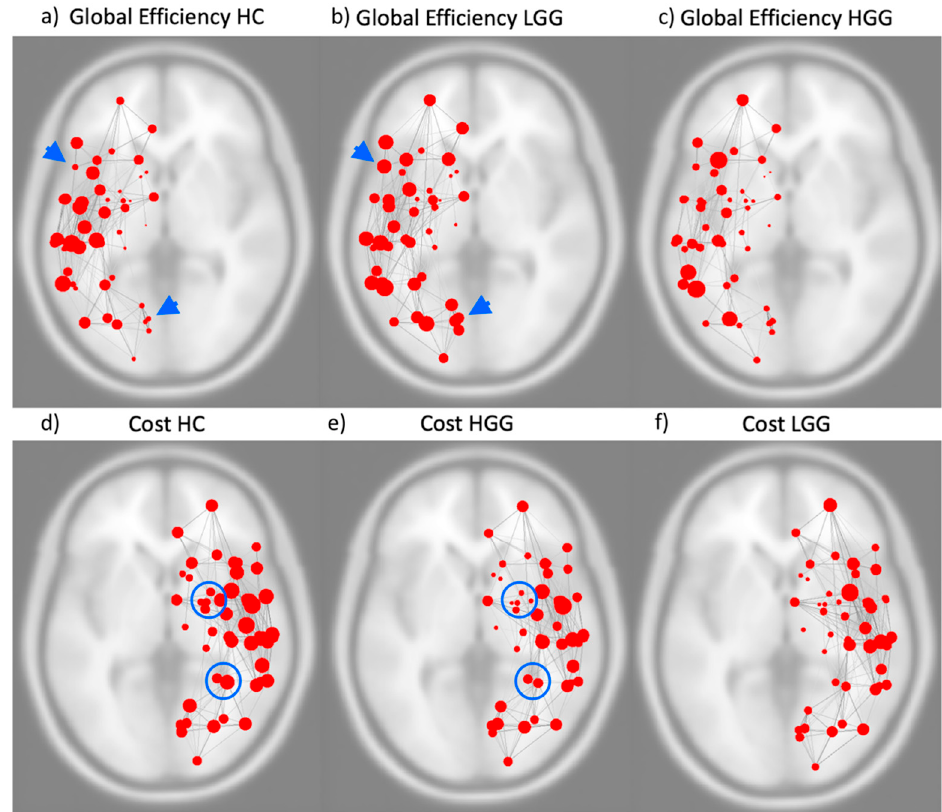
Figure 3. Images above represent the global efficiency of the left hemispheric functional network in healthy controls ( a ), patients with low-grade glioma (LGG) ( b ) and patients with high-grade glioma (HGG) ( c ). Blue arrowheads highlight examples of functional connectivity modification in communities of nodes. Images below represent the cost of the right hemispheric functional network in healthy controls ( d ), patients with HGG ( e ) and patients with LGG ( f ). Significant modifications were detected in the left hemispheric network of LGG compared to HC for global efficiency and in the right hemispheric network of HGG compared to HC for cost. Blue circles highlight examples of significant functional connectivity modifications in communities of nodes. The size of the red nodes represents the value of the respective graph theory metric. Table 2. Graph-theory statistics results for gliomas involving the temporal lobe. Significance is reported as FDR corrected p